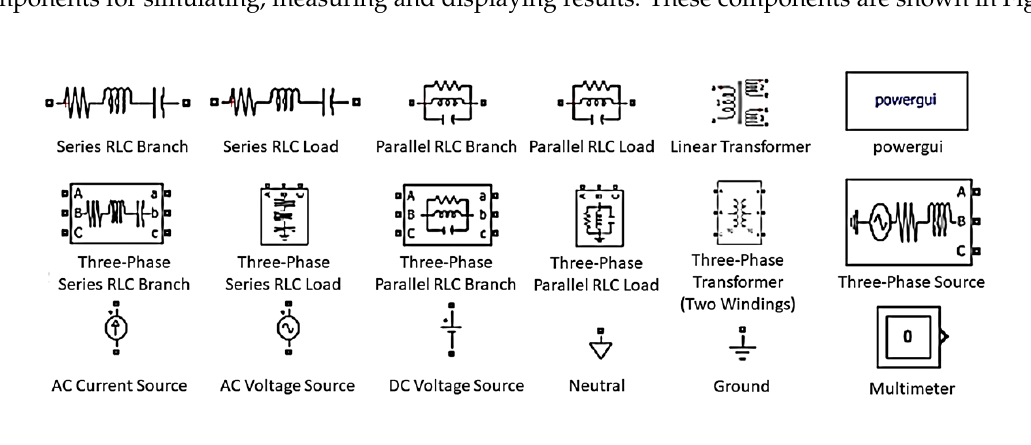
Figure 15. Specialized Technology models used in the